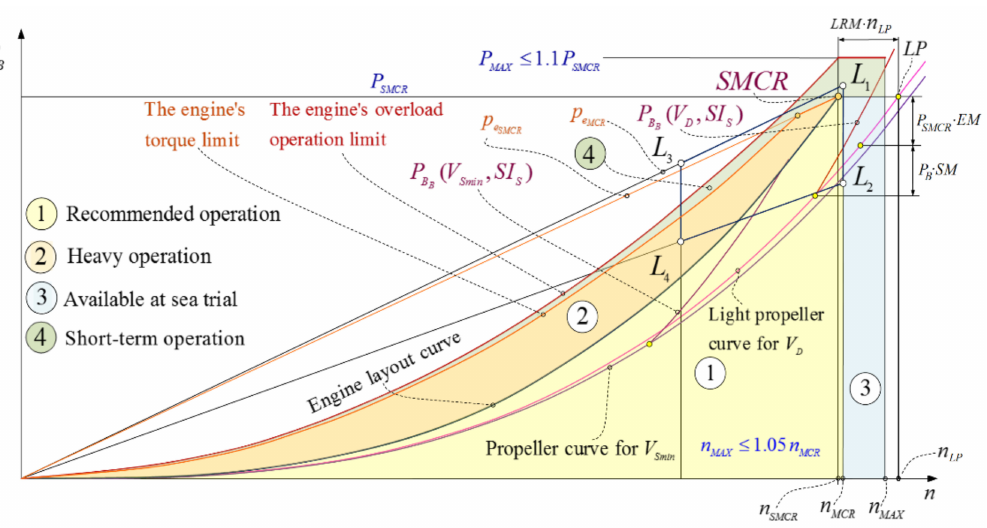
Figure 7. The engine layout diagram with light propeller curve, engine layout curve, and curves for different sea states and sailing speeds.